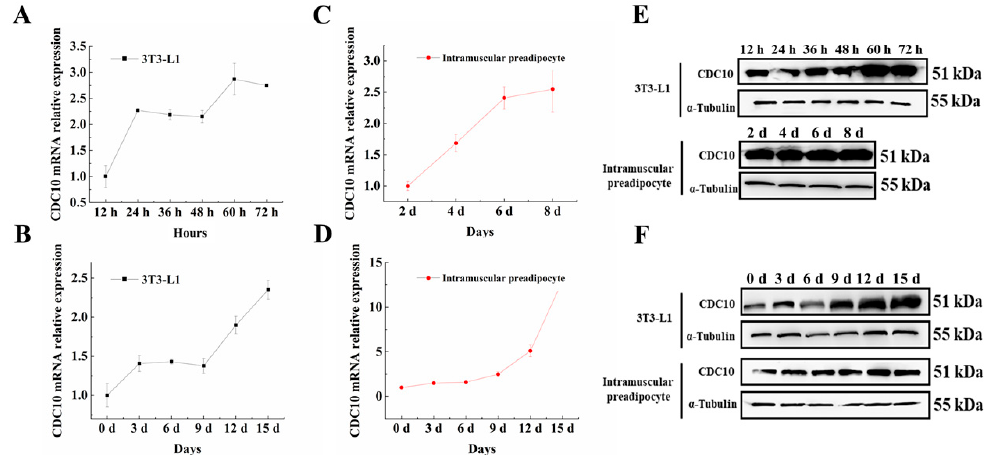
Figure 2. Expression of the CDC10 gene in the proliferation and differentiation of bovine intramuscular preadipocyte (BIMP) and 3T3-L1 cells. ( A , C ) Expression of CDC10 mRNA during the proliferation of BIMP and 3T3-L1 cells. ( B , D ) Expression of CDC10 mRNA during the differentiation of BIMP and 3T3-L1 cells. ( E , F ) Protein expression of CDC10 during the proliferation and differentiation of BIMP and 3T3-L1 cells. RT-PCR data was normalized to day 0, hour 12, and day 2. 3.4. Overexpression of CDC10 Had No Significant Effect on the Proliferation of BIMP